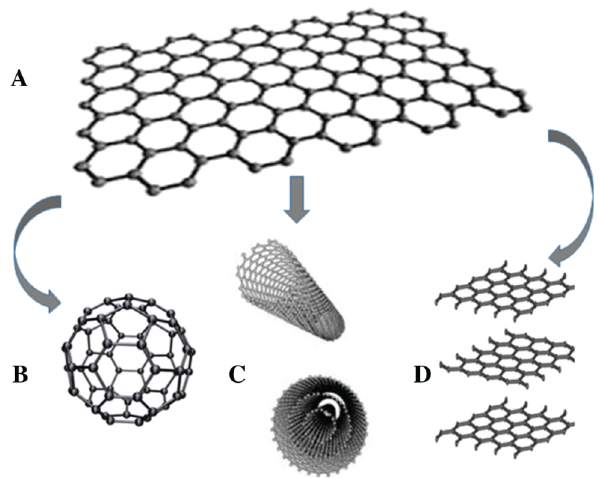
Figure 2: Schematic representation. (A) graphene (2D material) used as a precursor for the construction of carbon materials of other dimensionalities, such as (B) fullerene, (C) CNTs, and (D)